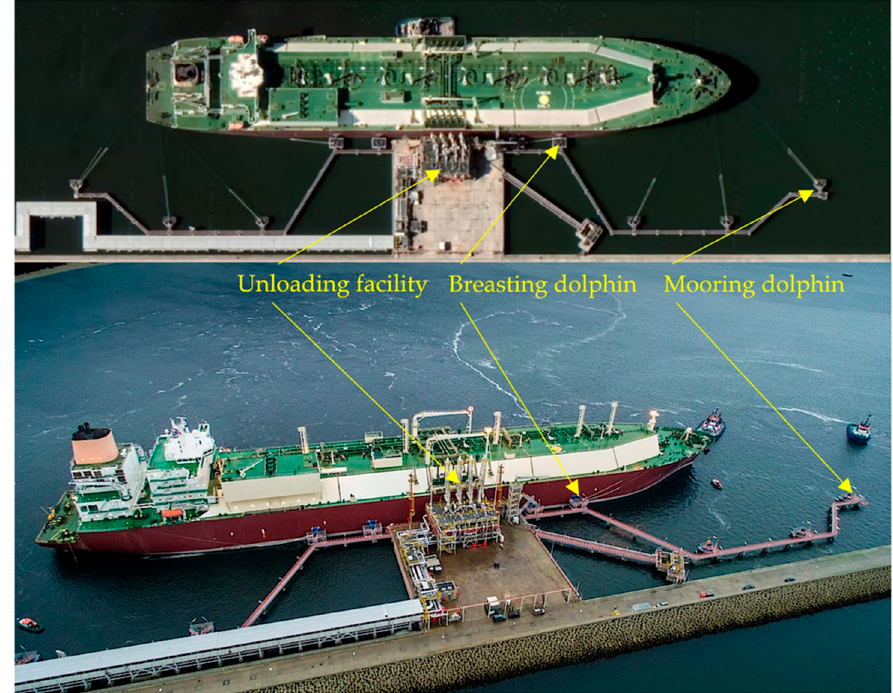
Figure 10. Unloading jetty and LNG carrier (based on [45]).